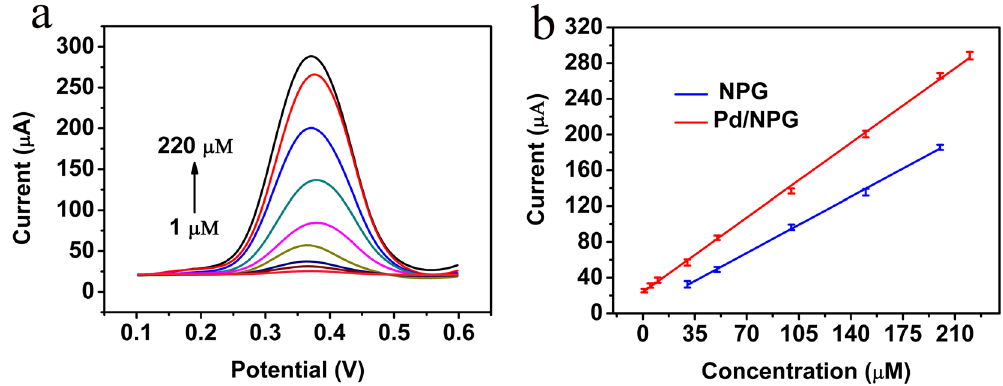
Figure 4. Detection of dopamine. ( a ) DPV curves of the Pd/NPG wire biosensor at various concentrations of DA (from 1 to 220 μΜ ). ( b ) Plots of the anodic peak currents versus the concentrations of DA of Pd/NPG wire biosensor (1, 5, 10, 30, 50, 100, 150, 200, 220 μΜ ) and NPG wire biosensor (30, 50, 100, 150, 200 μΜ